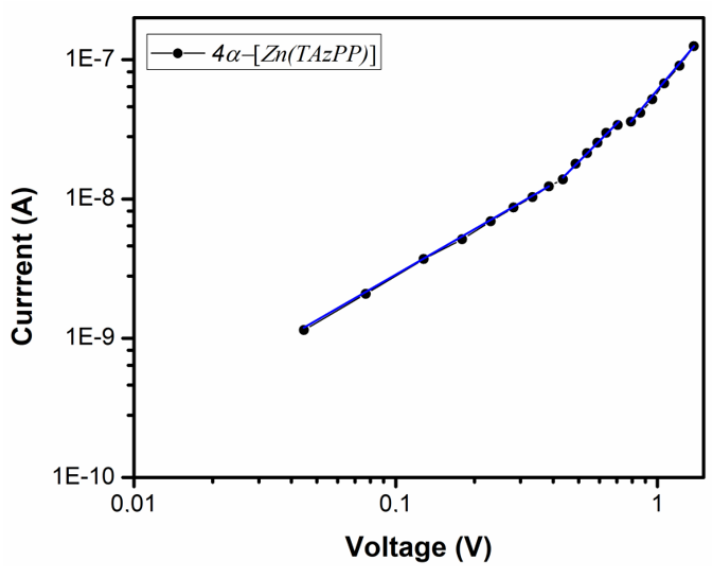
Figure 9. Log-log curve of complex ( 4 ) structure.